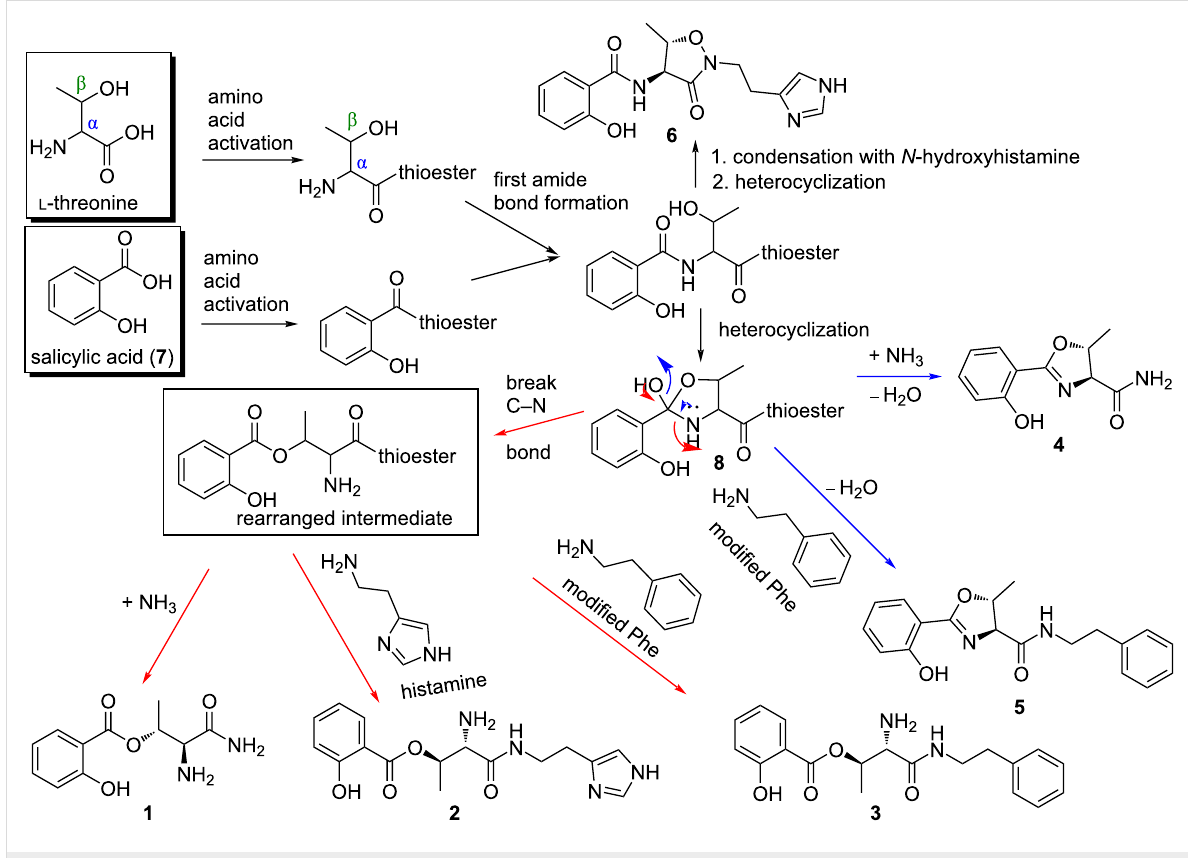
Figure 3: Plausible biosynthetic hypotheses of compounds 1 – 5 .